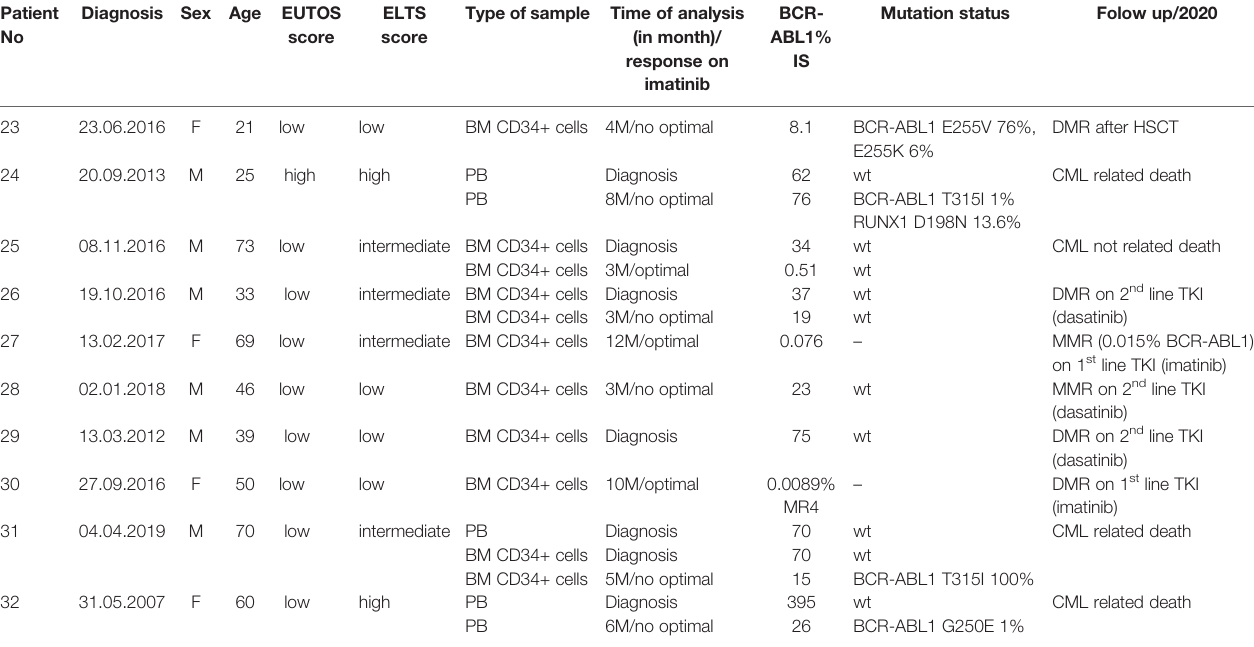
TABLE 2 | Characteristics of patients and samples used for the evaluation of gene expression analysis of DNA repair and response to DNA damage genes. Patient Diagnosis Sex Age EUTOS No